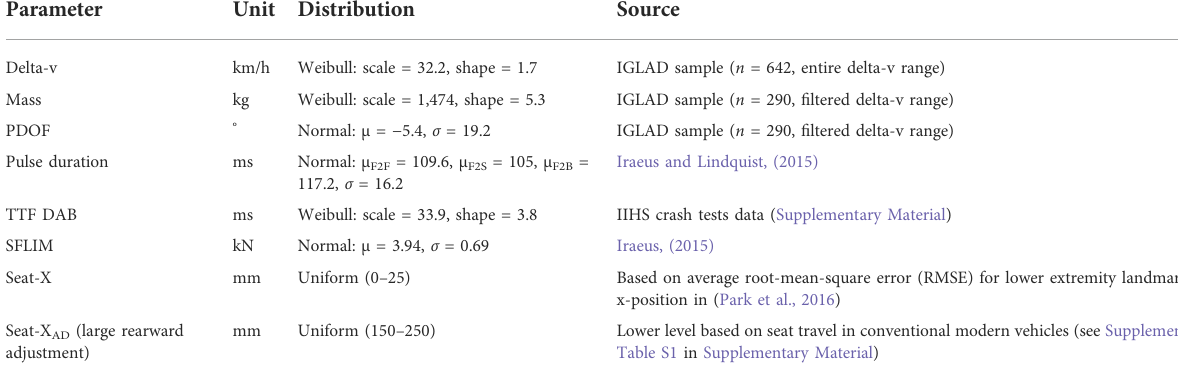
TABLE 1 Stochastically varied input parameters in the FE